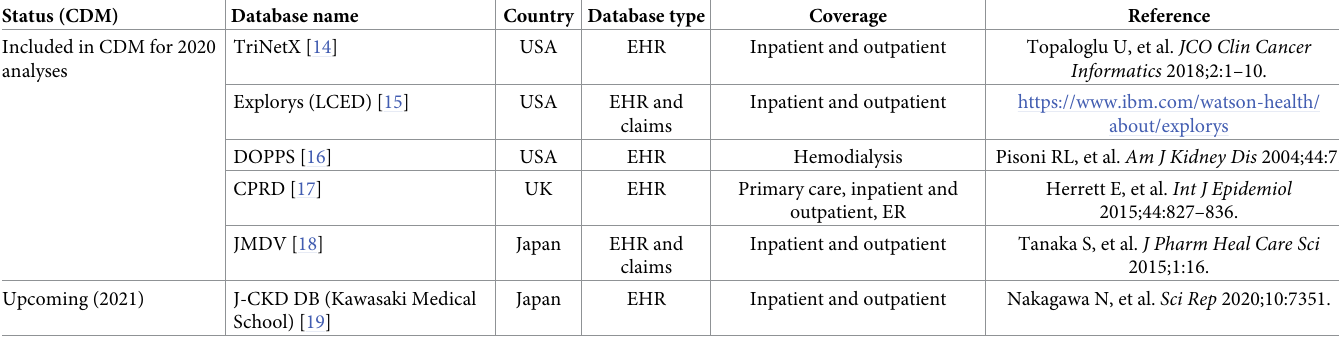
Table 1. Established databases included in DISCOVER